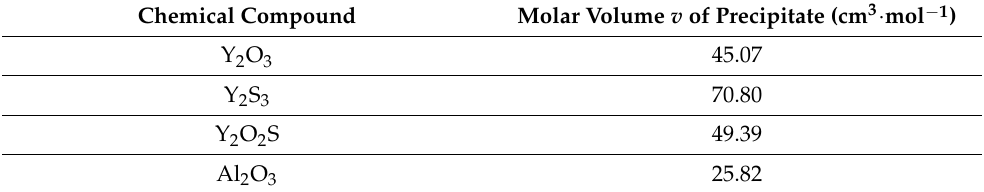
Table 5. Calculated molar volumes of selected non-metallic